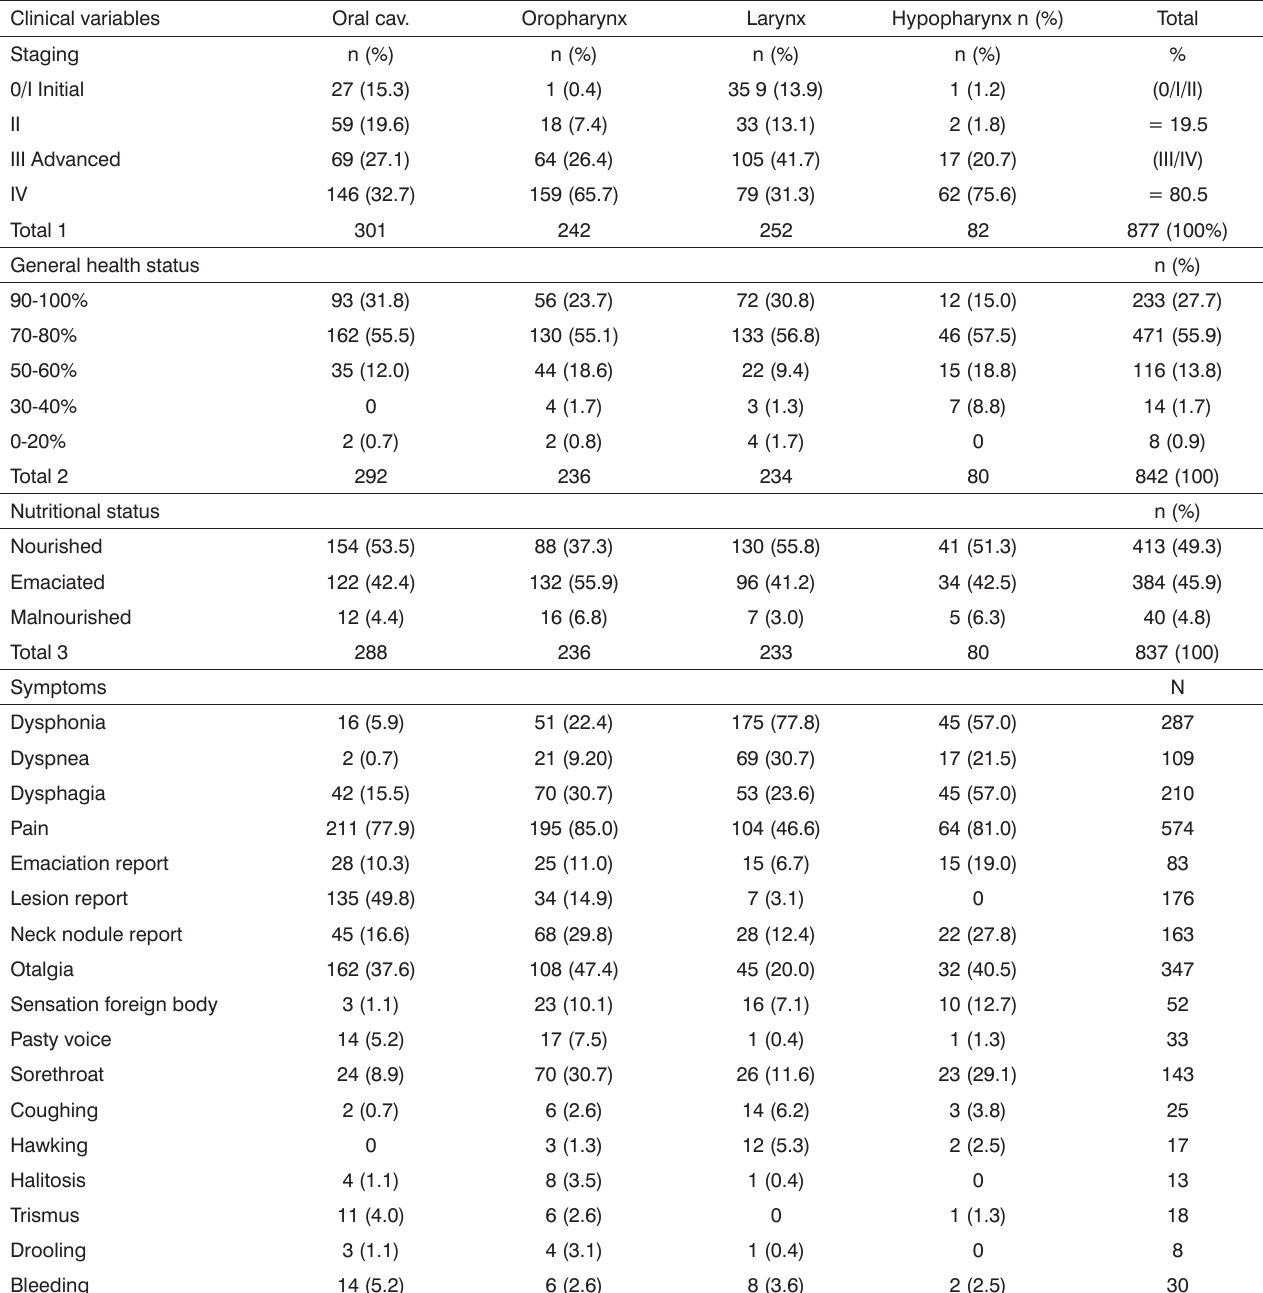
Table 1. Distribution and frequency of patients with UADT SCC by anatomical site, according to staging (cTNM), general health, nutritional status and